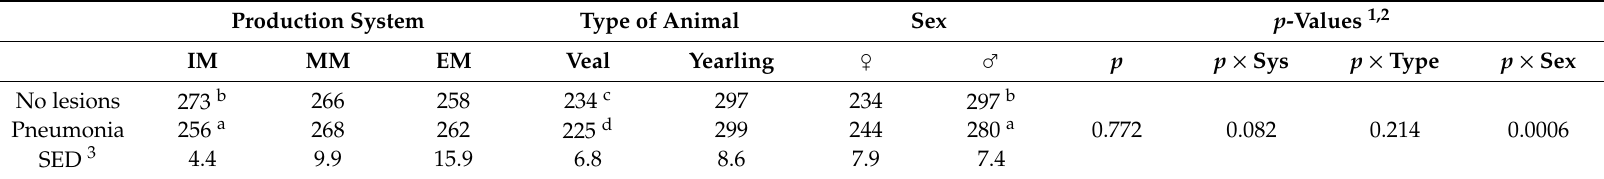
Table 4. E ff ect of the subclinical pneumonia on carcass weight (kg) at slaughter for the di ff erent production systems (IM: intensive management; MM: mixed management; EM: extensive management), type of animal (Veal vs. Yearling) and sex. Production System